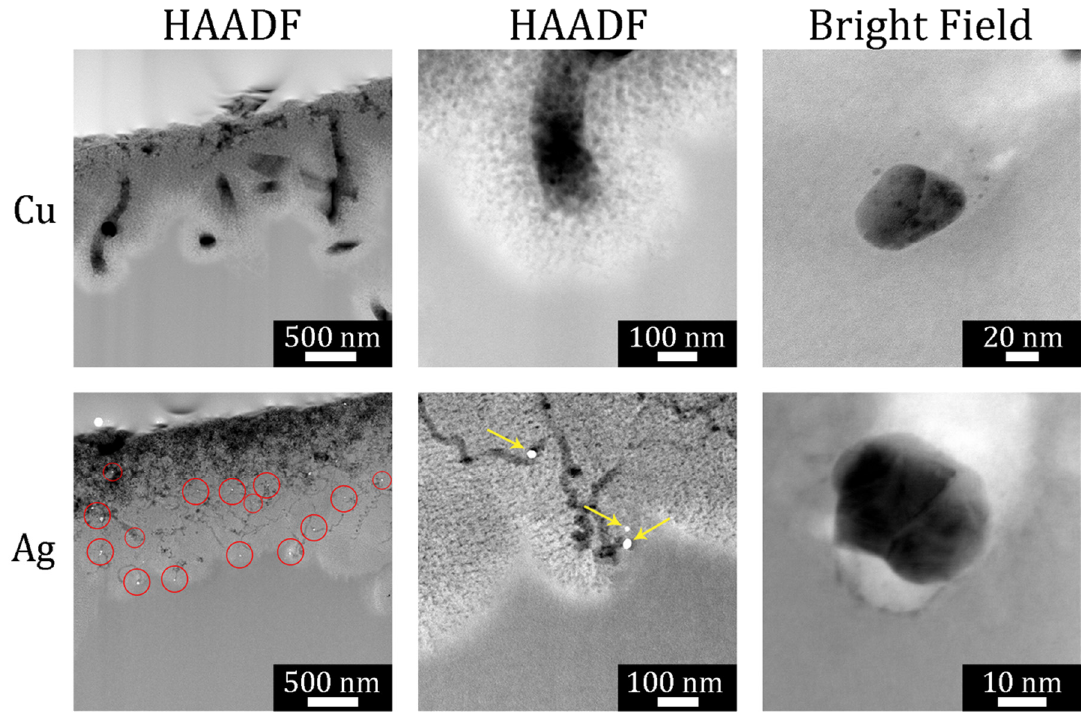
Figure 5. HAADF STEM image of FIB-cut cross section of a metallurgical grade Si particle etched with LL-MACE catalyzed by either Cu or Ag nanoparticles (first two columns). The bright field images in the third column show individual Cu (upper) and Ag (lower) nanoparticle catalysts embedded in Si after etching. Ag nanoparticles are observed as bright spots. Local etching results in uncorrelated, meandering etch track pores, while tortuous mesopores are created by remote etching. Reproduced with permission from Ref. [66]. Copyright © 2020, American Chemical Society.